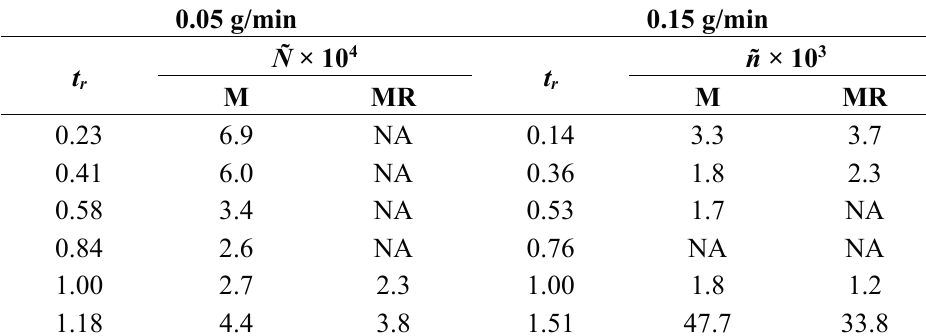
Figure 10. Evolution of polymerization rate with global conversion in polymerizations at 0.05 ( a ) and 0.15 ( b ) g/min in organic phase dosing rate. Runs M ( Table 3. Evolution of ñ values along